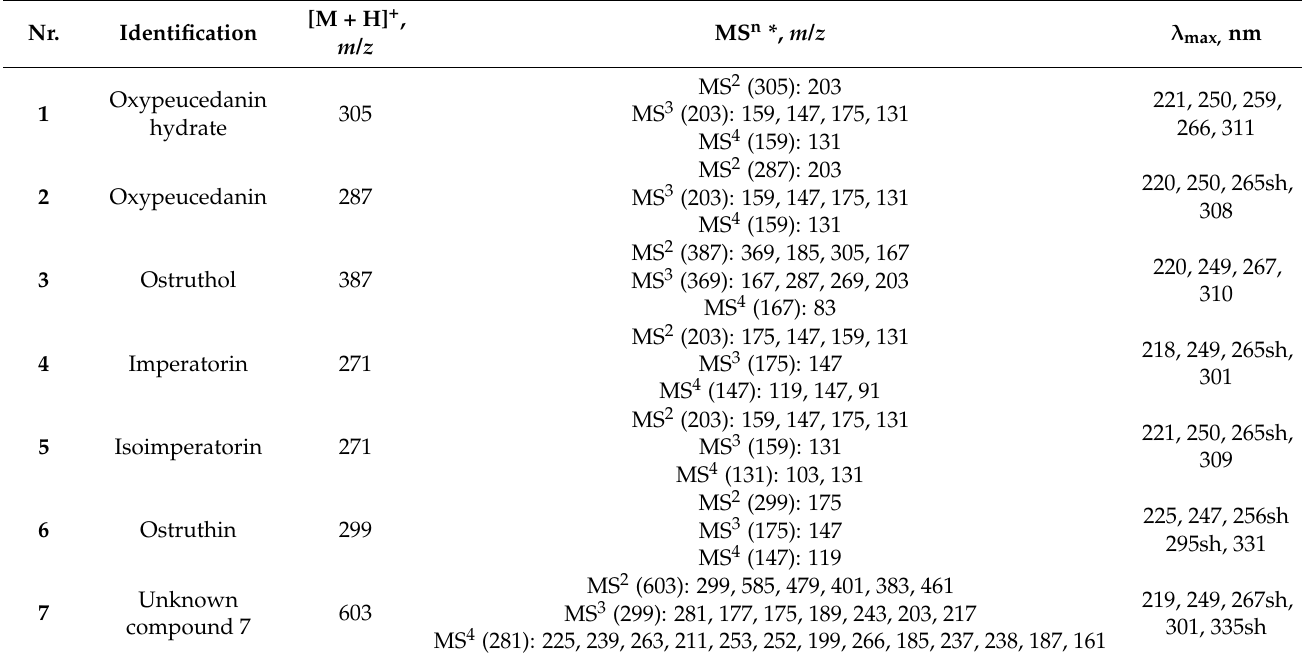
Table 1. MS n Fragmentation and UV maxima of main coumarins identified in Peucedanum ostruthium extracts and subsequent fractions, * relative fragment intensities in MS n > 10%.